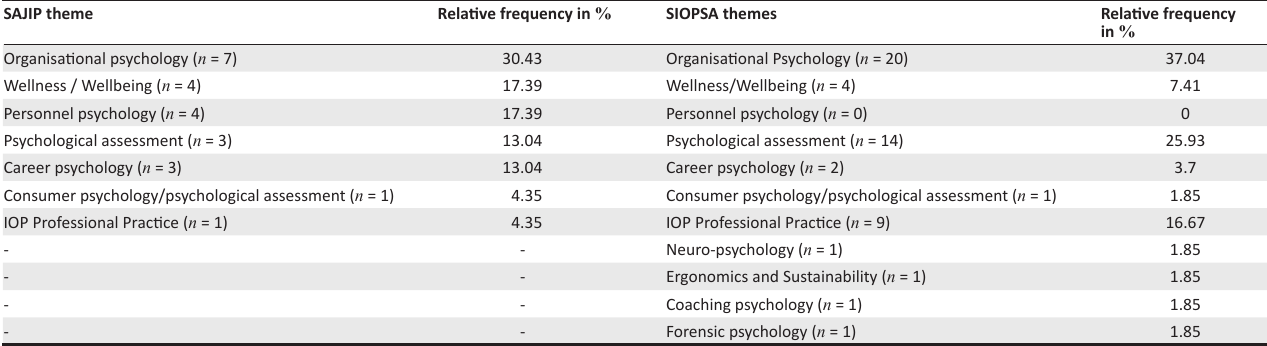
TABLE 3. Comparison of relative frequency of themes in SAJIP vs. SIOPSA’s 17th Annual